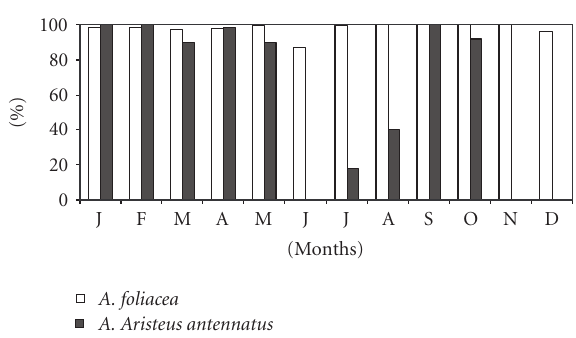
Figure 5: Monthly occurrence of reproductive males of Aristaeo- morpha foliacea and Aristeus antennatus from the eastern Ionian